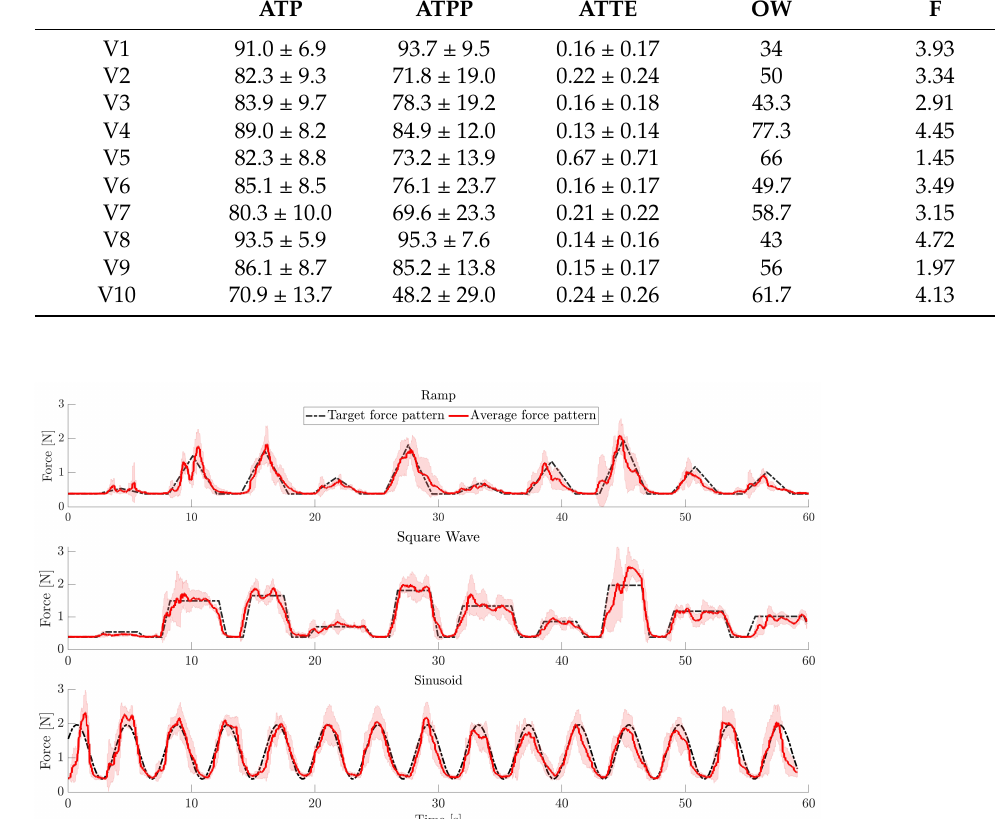
Table 3. ATP (%), ATPP (%), ATTE (-), OW (-), and maximum grip force F (N) for each volunteer (V).